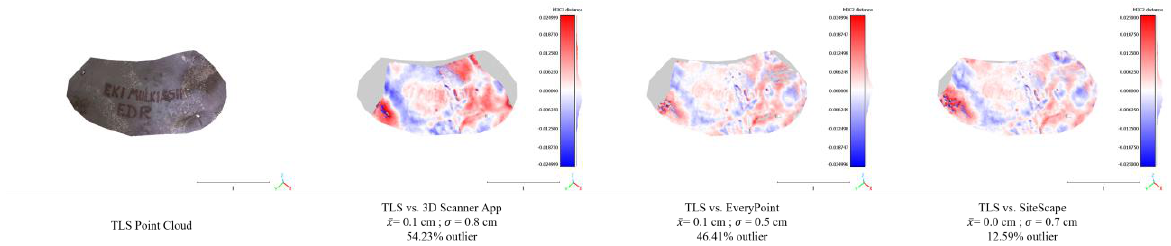
Figure 5 . The comparison in case (1) is between TLS and iPad LiDAR using M3C2 analysis in Cloud Compare. The gray area represents an